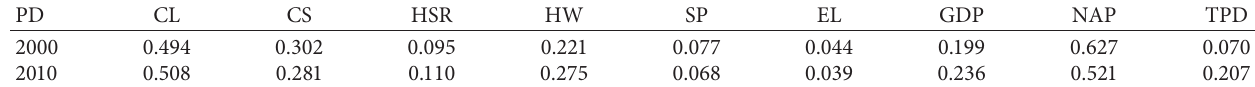
Table 4: Results of the factor detector.